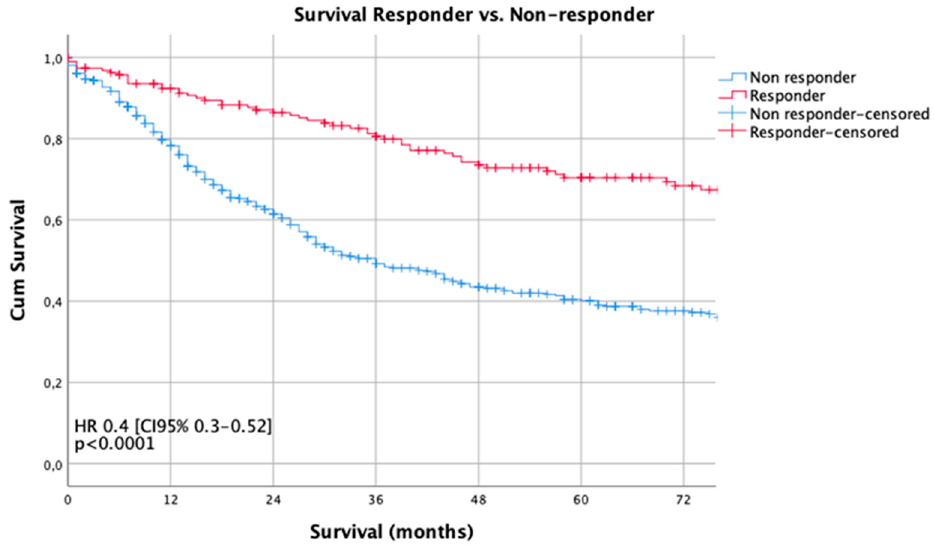
Figure 1. Survival curves according to histopathologic regression (HPR). The Kaplan-Meier method and the log-rank test were used to compare the estimated survival by histopathologic responders and non-responders.